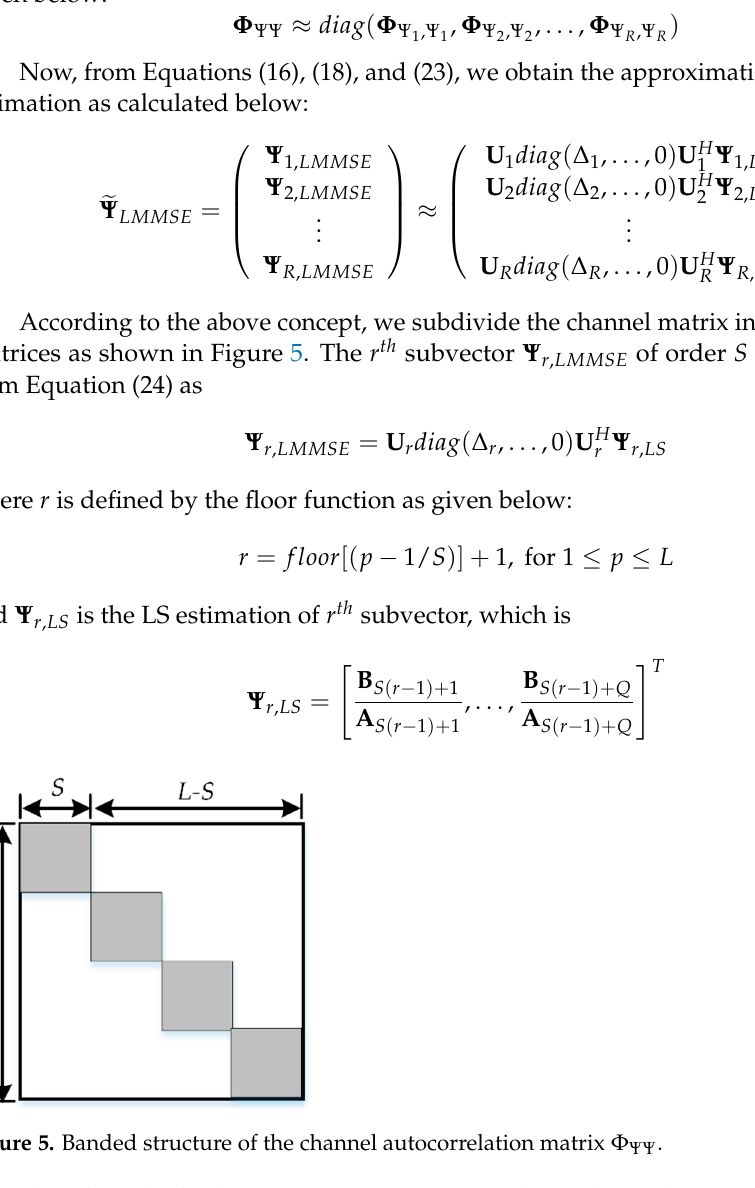
. From Figure 6c, the LMMSE estimation